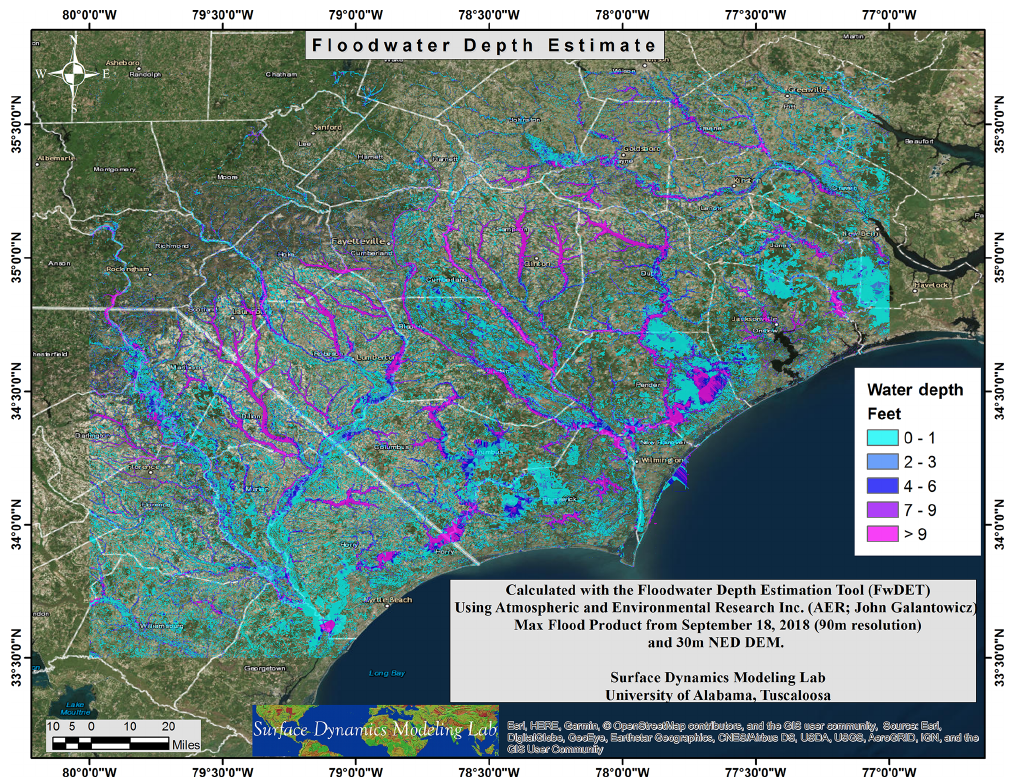
Figure 5. A floodwater depth map which was shared during the GFP Hurricane Florence activation. Water depth was calculated with FwDET v2.0 using a maximum inundation extent map (as of 18 September 2018) and a 30m DEM (NED). Units were converted to US cus- tomary units for better integration in US emergency response entities. Background sources: Esri, DigitalGlobe, GeoEye, i-cubed, USDA FSA, USGS, AEX, Getmapping, Aerogrid, IGN, IGP, swisstopo, and the GIS user community. © OpenStreetMap contributors 2019.